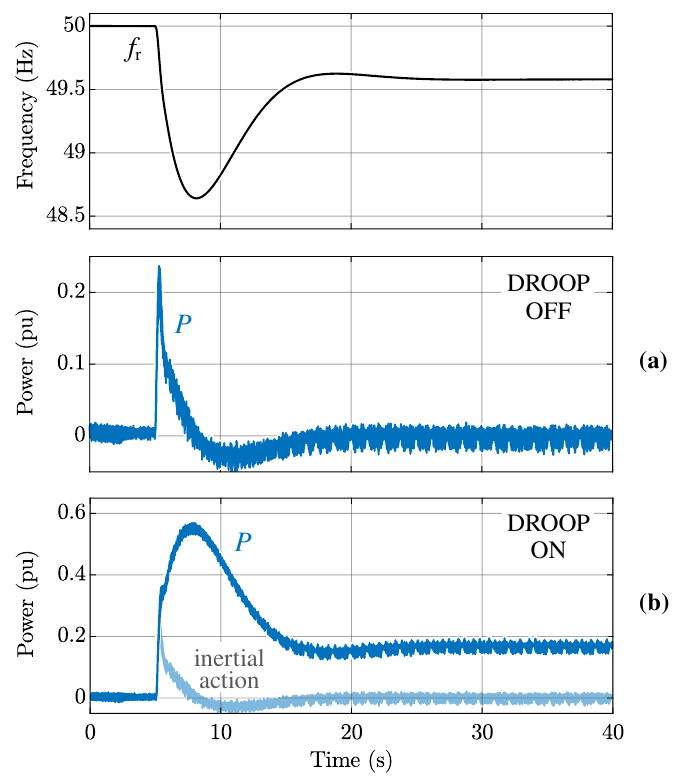
Figure 12. Frequency regulation tests. ( a ) The S-VSC reacts to the grid frequency variation by injecting active power into the grid during the transient (inertial behavior). ( b ) A droop control reference is added in parallel to the S-VSC, injecting active power also after the frequency is settled.